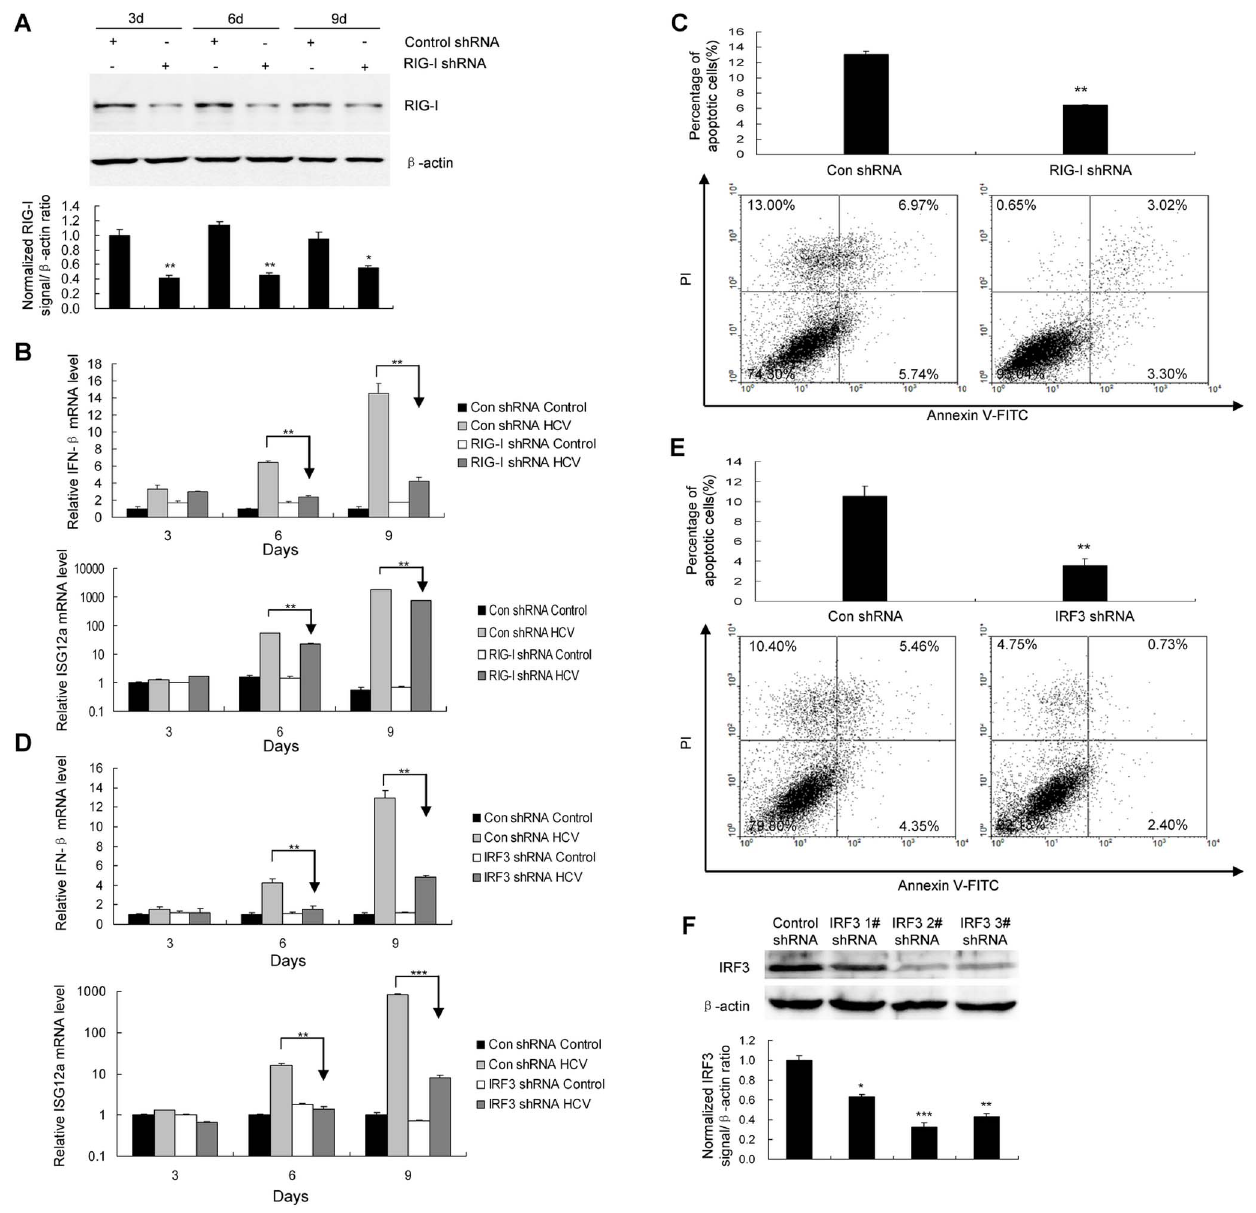
Figure 4. Induction of IFN- b and apoptosis by HCV infection is mediated through RIG-I and IRF-3. ( A ) Confirmation of RIG-I knockdown with RIG-I-specific shRNA in HLCZ01 cells. RIG-I shRNA or control shRNA was delivered into HLCZ01 cells followed by HCV infection. RIG-I protein was determined by western blot. ( B ) Knocking down RIG-I inhibits the induction of IFN- b and ISG12a by HCV infection in HLCZ01 cells. HLCZ01 cells were treated as described in part A. The expression of IFN- b or ISG12a mRNA was examined using real-time PCR and normalized with GAPDH. ( C ) RIG-I knockdown blocks HCV-induced apoptosis of HLCZ01 cells. RIG-I shRNA or control shRNA was delivered into HLCZ01 cells followed by HCV infection for 9 days. Apoptosis of HLCZ01 cells was examined using flow cytometry. ( D ) IRF-3 directly regulates IFN- b and ISG12a mRNA expression in HCV- infected HLCZ01 cells. HLCZ01 cells were transfected with control shRNA or IRF-3–specific shRNA for 24 hours, followed by JFH-1 infection. The expression of IFN- b and ISG12a was detected using real-time PCR analysis and normalized with GAPDH. ( E ) Knockdown of IRF-3 reduces apoptosis of HCV-infected HLCZ01 cells. HLCZ01 cells were treated as described in part D. The cells were harvested for flow cytometry. ( F ) The knockdown efficiency was examined by western blot analysis using anti–IRF-3 antibody. The abbreviation ‘‘con’’ is for ‘‘control’’ in the figures. If not stated otherwise bar graphs represent means of three independent experiments. doi:10.1371/journal.pone.0094501.g004 assays using a plasmid harboring ISG12a3 9 UTR(Mut), where the the level of ISG12a in HLCZ01 cells. Overexpression of miR-942 binding sites for miR-942 were inactivated, we did not observe upon transfection significantly decreased ISG12a level in compar- inhibitory effect of miR-942 on luciferase activity (Figure S3D). To ison with the control (Figure S3E). Knockdown of miR-942 by examine whether miR-942 affects ISG12a expression in HLCZ01 anti-miR-942 in HLCZ01 cells, which was confirmed by cells, we examined the effect of forced expression of miR-942 on quantitative real-time PCR (Figure S3F), increased ISG12a